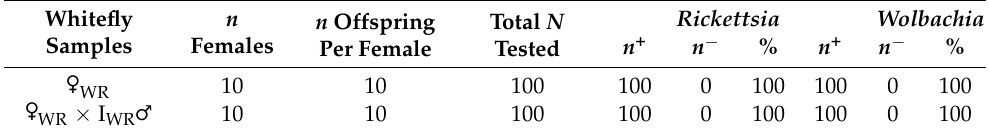
Table 1. Maternal transmission e ffi ciency of Ricke tt sia and Wolbachia of Asia Ⅱ 1 I WR line. Whitefly n Whitefly Samples Females